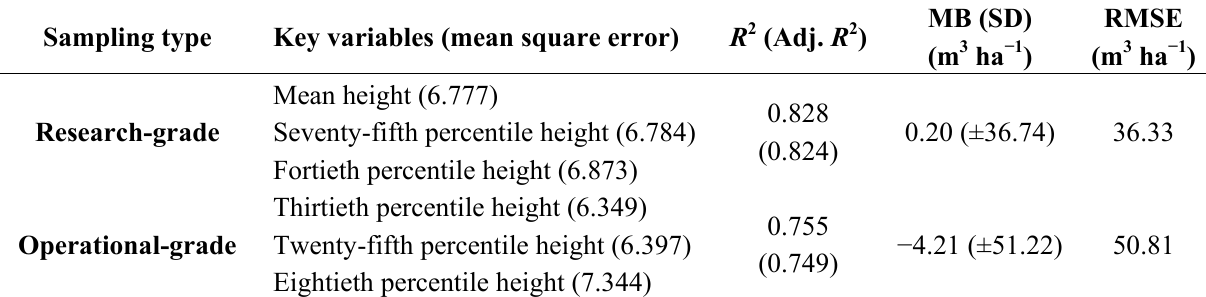
Table 5. Developed stem volume prediction models based on research- and operational-grade plot data with the three most key predictor variables regarding the coefficient of determination ( R 2 , adjusted R 2 , mean bias (MB) with standard deviation (SD) and root mean square error